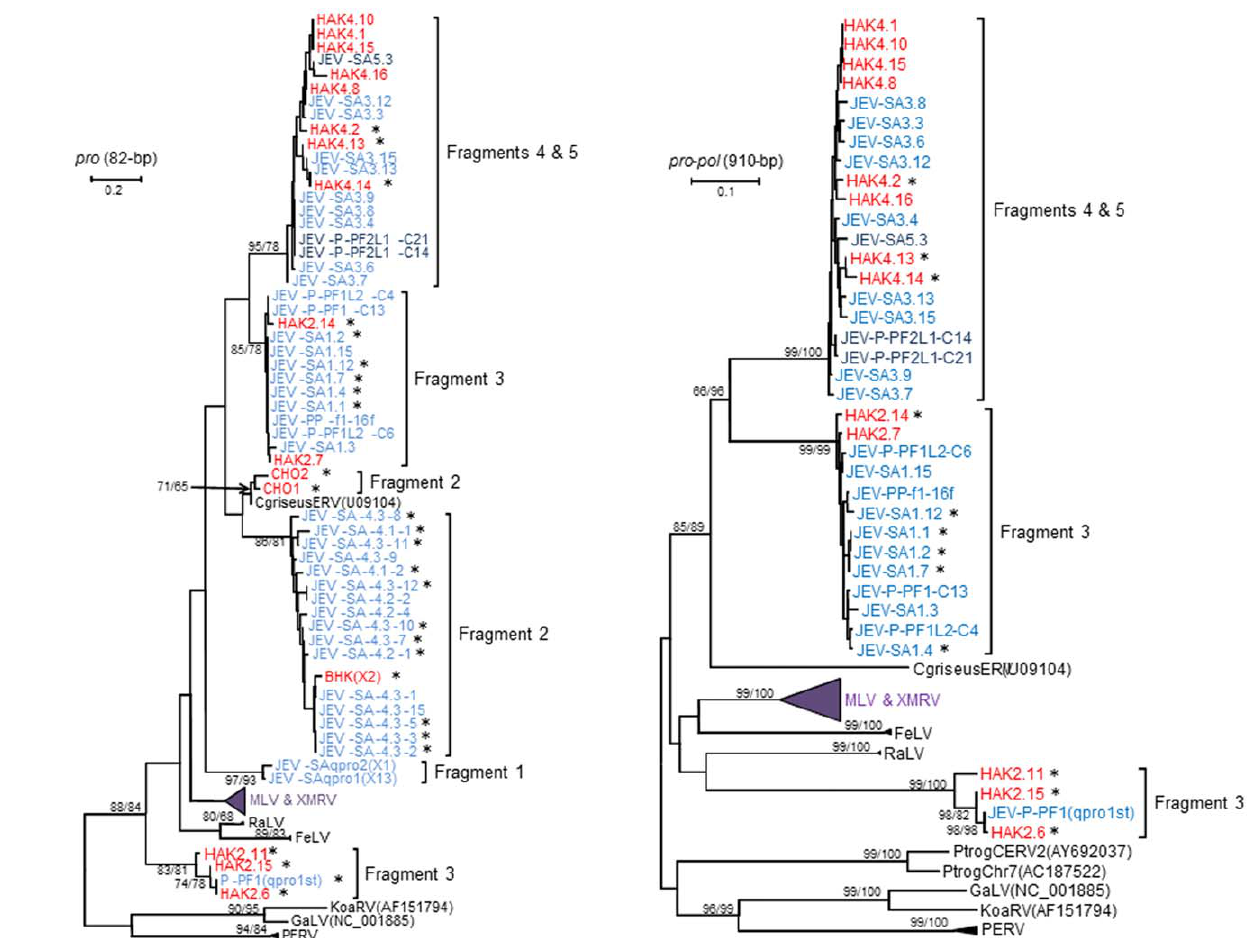
Figure 2. Identification of novel hamster endogenous gammaretrovirus sequences in the live attenuated Japanese encephalitis virus (JEV) vaccine (SA-14-14-2). (a) Phylogenetic inference of 91-bp overlapping (final alignment length is 82-bp) gammaretrovirus DNA sequences PCR-amplified from the JEV SA-14-14-2 vaccine and hamster cell lines (baby hamster kidney (BHK) and Chinese hamster ovary (CHO)) using five different PCR assays. (b) Phylogenetic inference of 910-bp gammaretrovirus DNA sequences PCR-amplified from the JEV SA-14-14-2 vaccine and HAK using three different PCR assays. The new sequences were phylogenetically compared to prototypical gammaretroviruses (GenBank accession numbers in parentheses). MLV, murine leukemia virus; mERV, mouse endogenous retrovirus; FeLV, feline leukemia virus; RaLV, rat leukemia virus; PtrogCERV, Pan troglodytes chimp endogenous retrovirus; GaLV, gibbon ape leukemia virus; KoaRV, koala retrovirus; PERV, porcine endogenous retrovirus. XMRV sequences coded with VP and WPI are from persons with prostate cancer and chronic fatigue syndrome, respectively. X followed by a number in parentheses indicates the number of identical sequences obtained for that fragment. Asterisks indicate sequences without open reading frames. The MLV/XMRV and PERV branches were collapsed to fit the trees to single pages. Stability of the tree topology was tested using 1000 bootstrap replicates in both neighbor joining (NJ) and maximum likelihood (ML) methods. Bootstrap values . 60 are shown (NJ/ML). New sequences (fragments 1–4) from the JEV vaccine and hamster cell lines are in light blue and red text, respectively. Fragment 5 sequences amplified from the JEV SA-14-14-2 vaccine are in dark blue text.